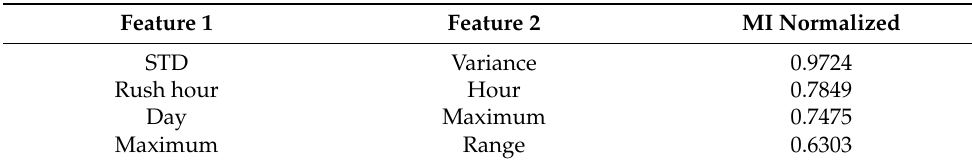
Table 7. Features with MI greater than 0.6 between